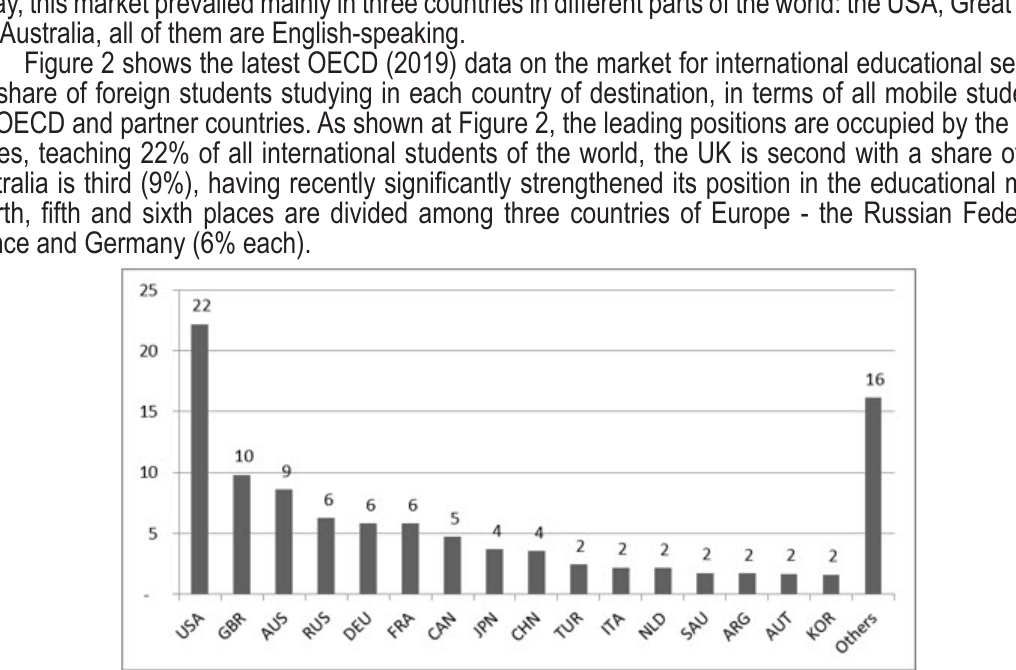
Figure 2. International students enrolled in each destination country as a share of all mobile students in OECD and partner countries (2017), %